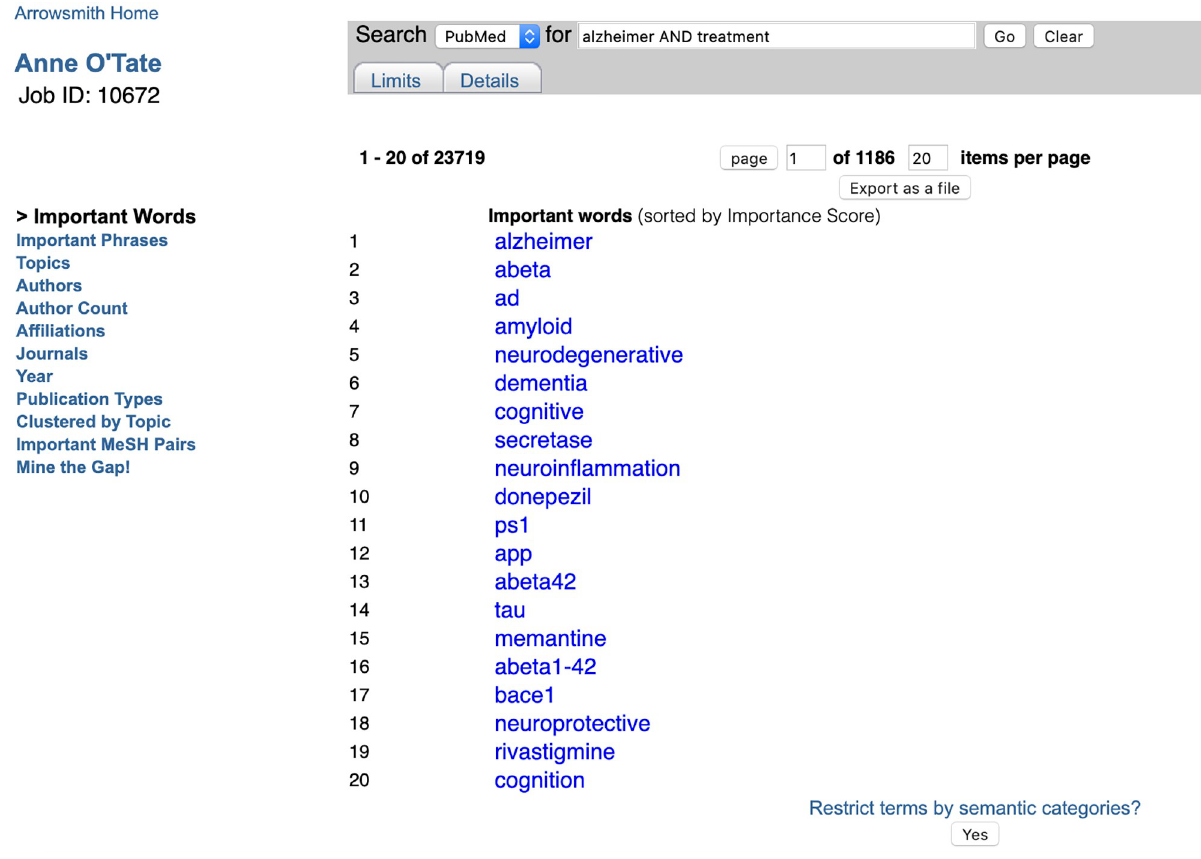
Fig 3. Screenshot of important words calculated for the query [Alzheimer AND